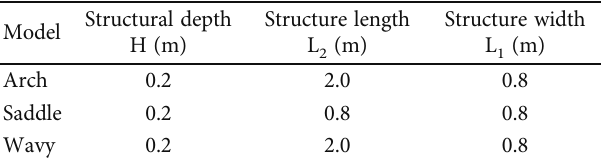
Figure 1: Comparison diagram of wind pressure coe ffi cient. C the wind pressure coe ffi cient. Di ff erent points are analyzed by di ff erent methods (square for canopy measurement; circle for RSM; triangle for LES). Table 1: Dimensions of the calculation model. Structural depth Model H